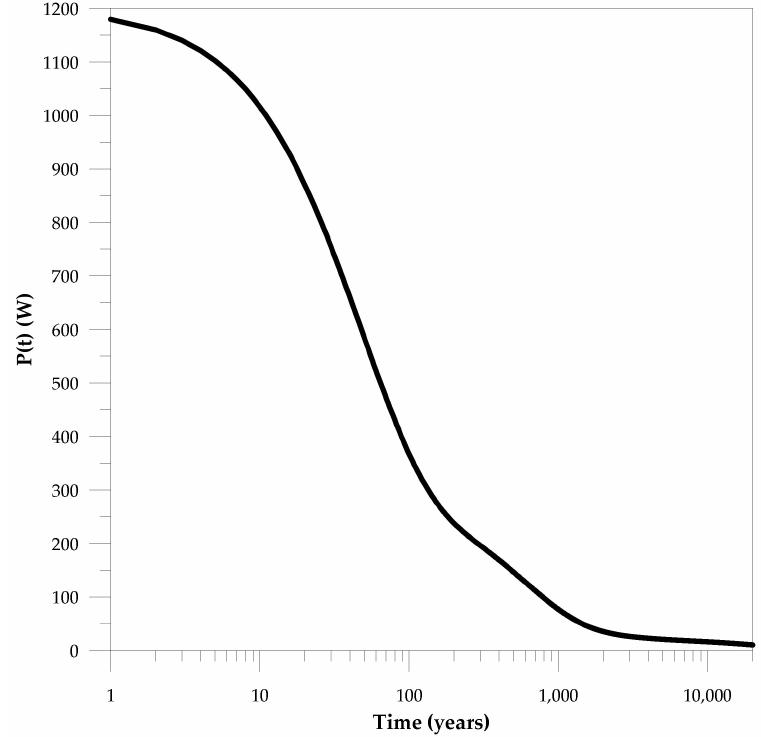
Figure 9. Canister power as a function of time.